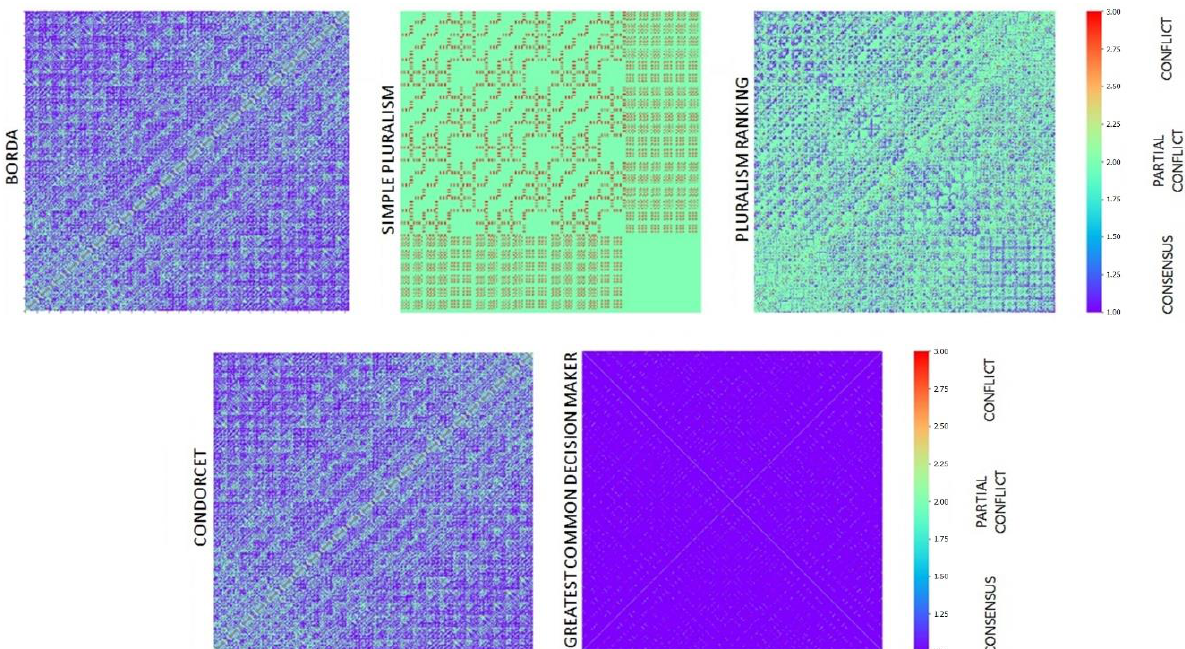
Figure 19. Comparison of all voting methods for 4 × 4 matrices.